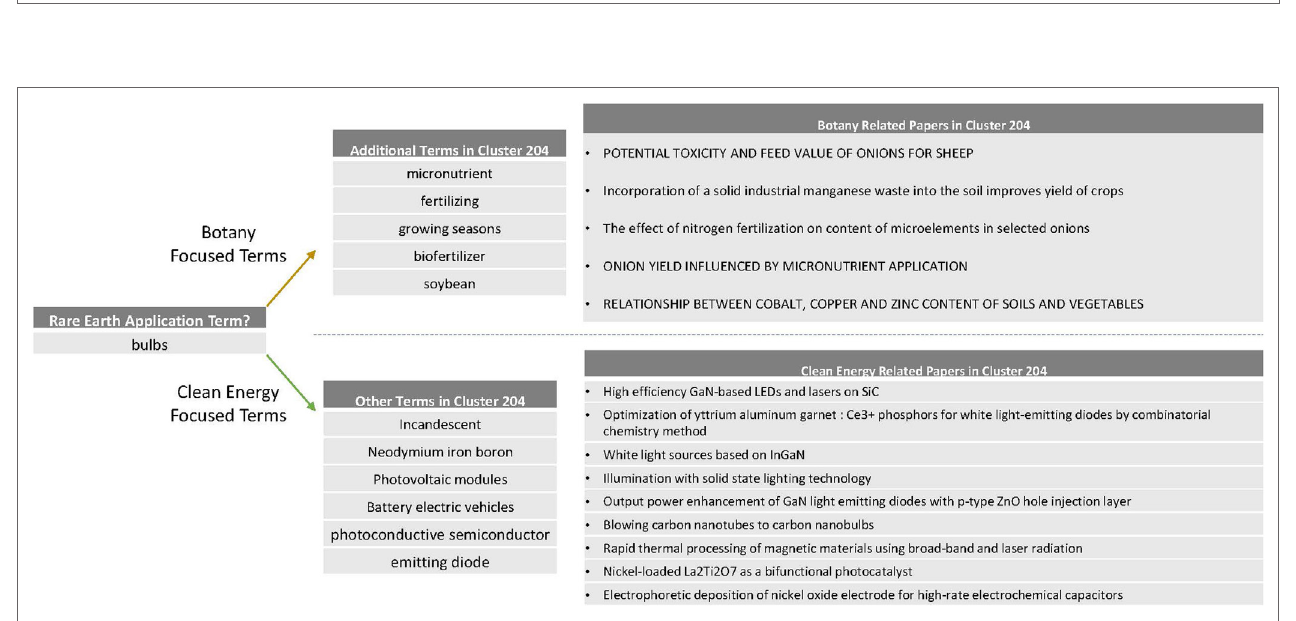
FigUre 5 | Unfocused clusters were then sub-clustered to produce more useable and focused clusters, as shown in this figure. A blub term cluster was split. The sub-clustering algorithms produced two new clusters, as shown above. The new smaller clusters were more focused than the larger